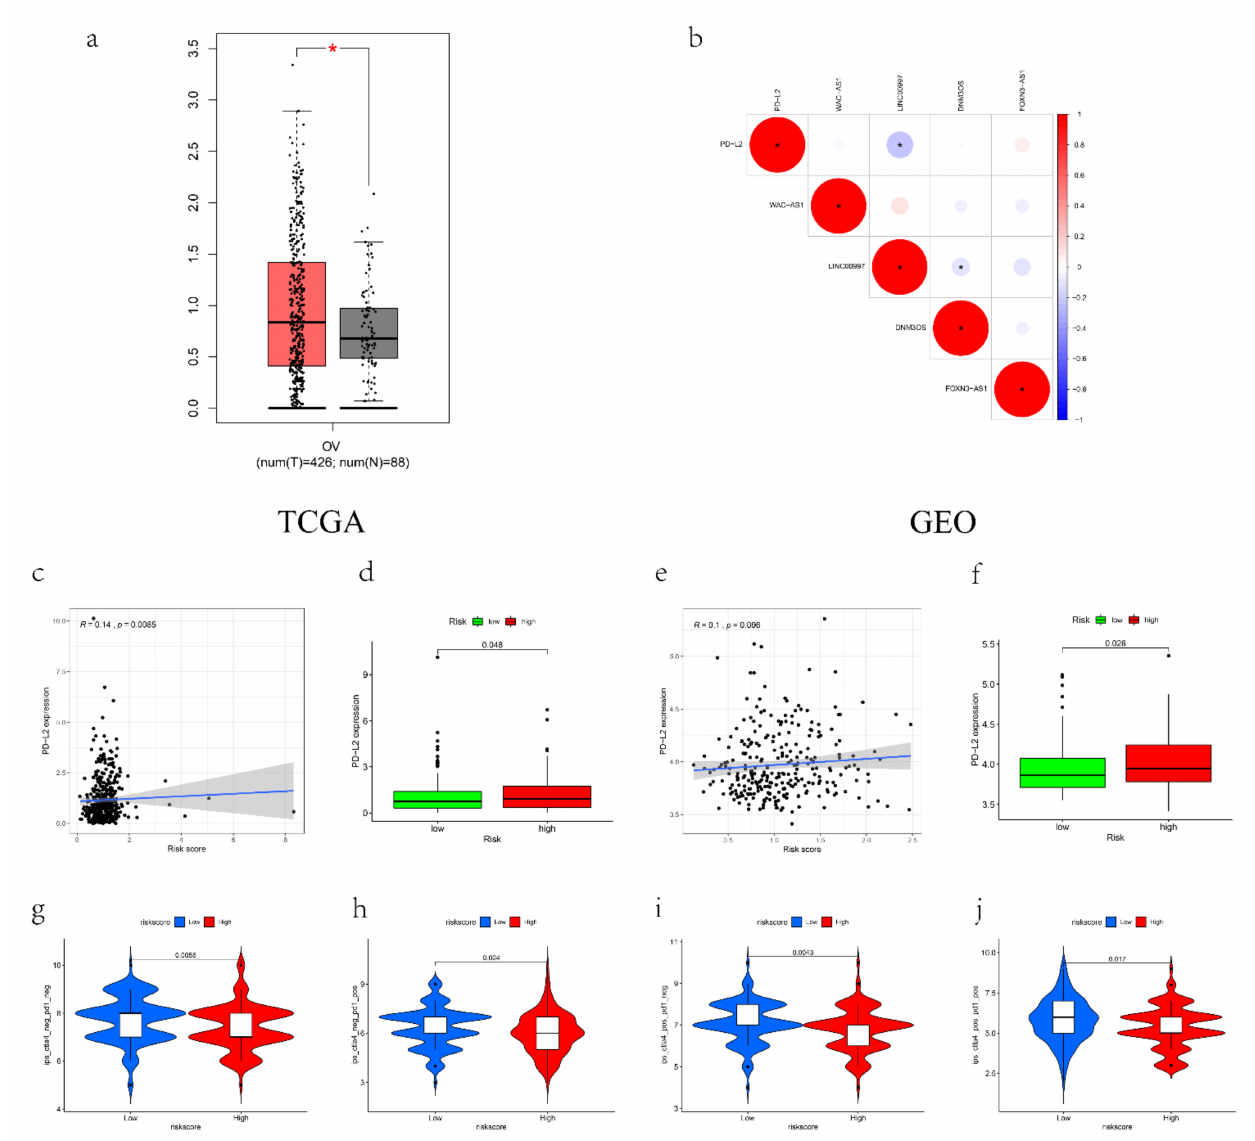
Figure 6. IPSs and immunotherapy gene expression analysis. ( a ) The expression of PD-L2 in tumor and normal tissues. ( b ) The correlation between the mRLs and PD-L2. ( c – f ) The expression of PD-L2 in low- and high-risk groups in TCGA and GEO datasets. ( g – j ) The IPSs of low- and high-risk groups. * p < 0.05. In TCGA-entire set, N = 374; In GEO set, N =